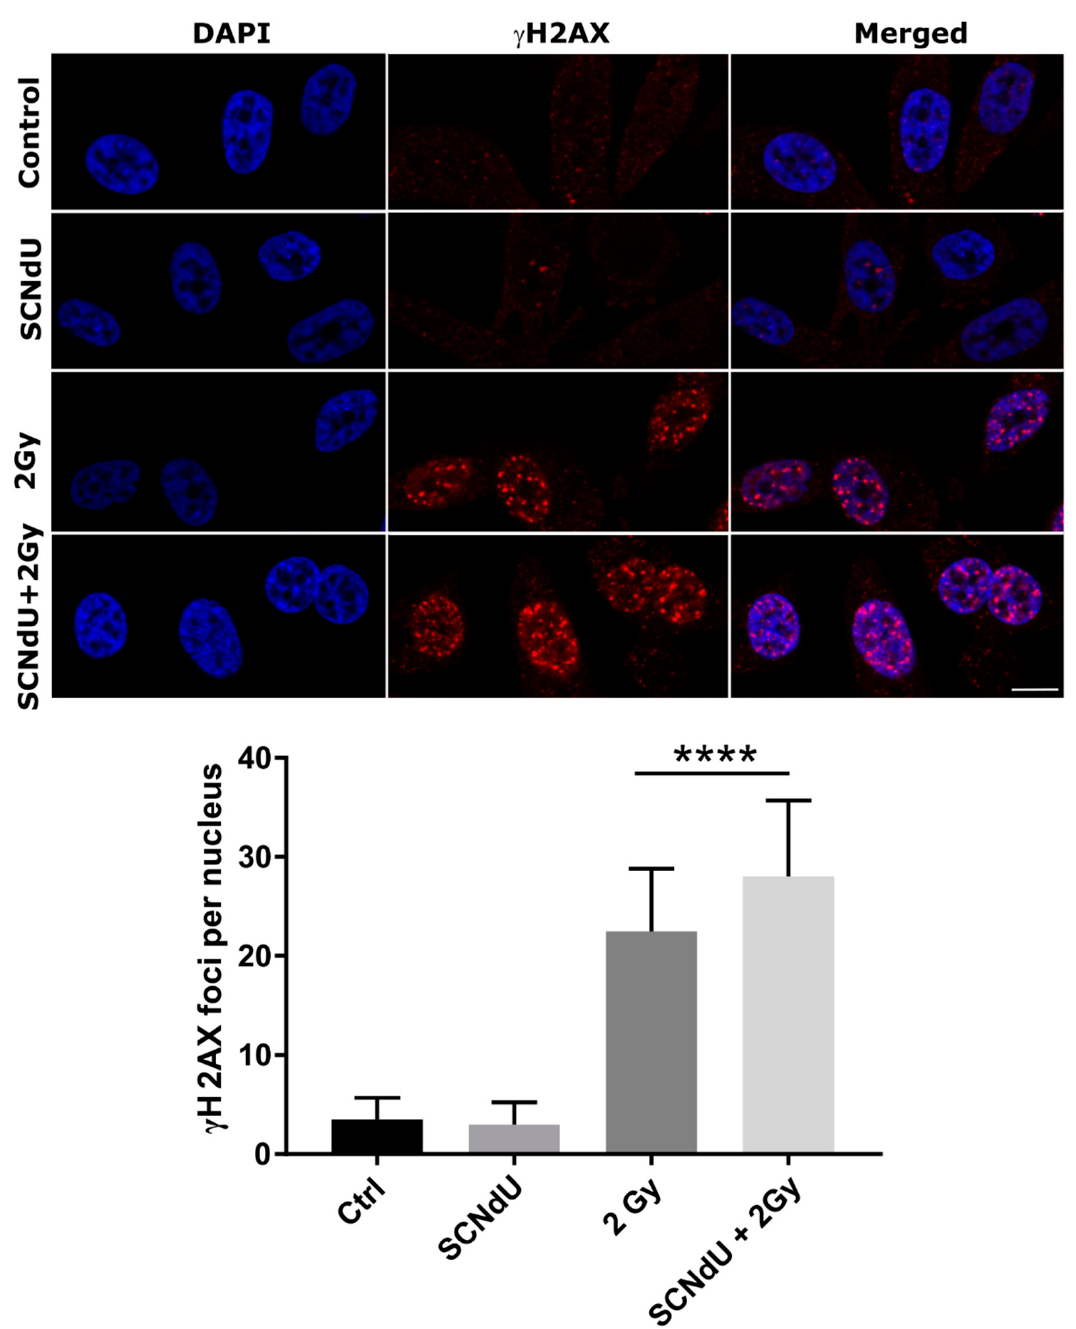
Figure 5. The representative images of γ H2A.X foci immunofluorescence staining in PC3 cells (control cells, treated with 50 µ M SCNdU, irradiated with 2 Gy, treated with 50 µ M SCNdU and irradiated with 2 Gy). Cells were harvested 1 h following IR. Slides were counterstained with DAPI to visualize nuclei (left panels). γ H2A.X foci were quantified as number of foci per nucleus. The results are shown as the mean ± SD. **** Statistically significant difference at p < 0.0001. Specimens were analyzed using confocal laser scanning microscope (Leica SP8X) with a 63 × oil immersion lens (Scale bar − 10 µm).